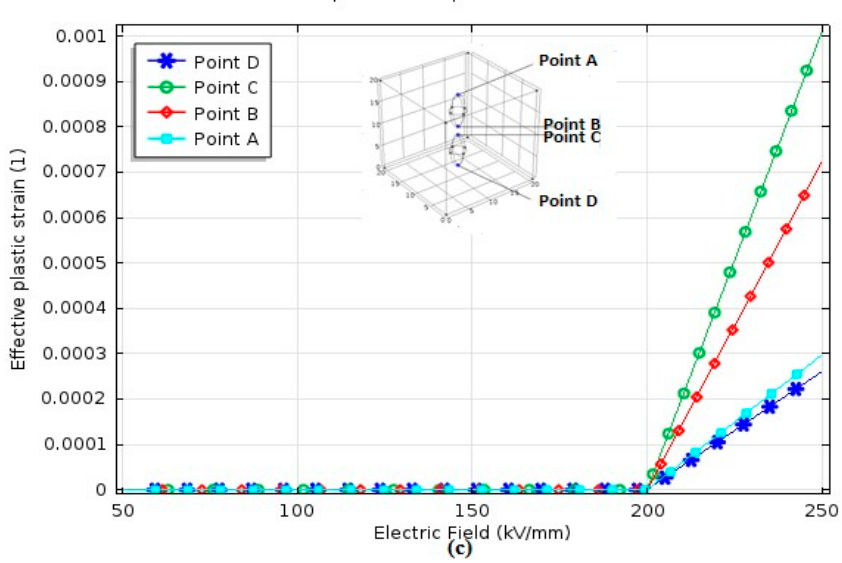
Figure18. E ff ectiveplasticstrainatthetipsofellipsoidswithincreasingelectricfield(50–250kV / mm)and Figure 18. Effective plastic strain at the tips of ellipsoids with increasing electric field (50–250 kV/mm) decrease in distance between points B and C: ( a ) distance: 0.5 µ m; ( b ) distance: 1 µ m; ( c ) distance: 2 µ m. and decrease in distance between points B and C: ( a ) distance: 0.5 µm; ( b ) distance: 1 µm; ( c ) distance: 2 µm.